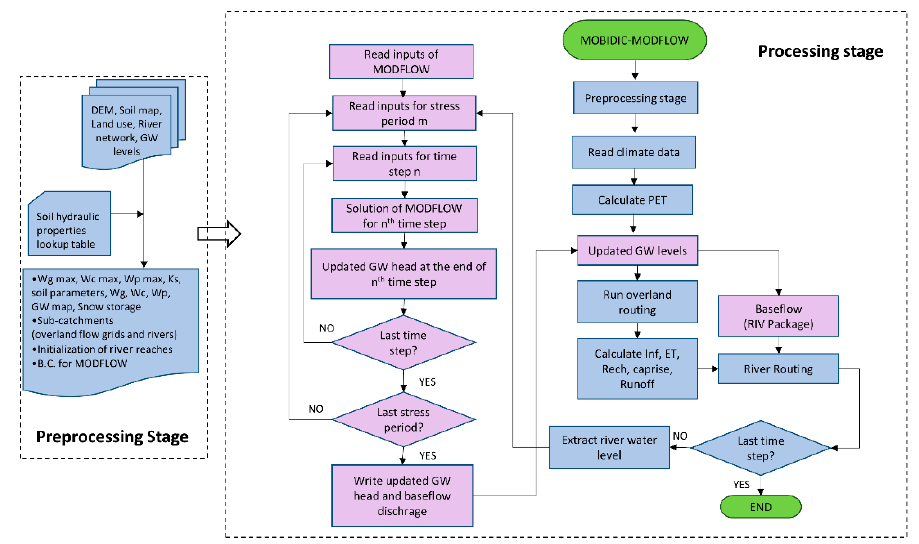
Figure 6. Flowchart showing integration procedure of MOBIDIC and MODFLOW. The blue and purple colors represent the process conducted in MOBIDIC and in MODFLOW, respectively.